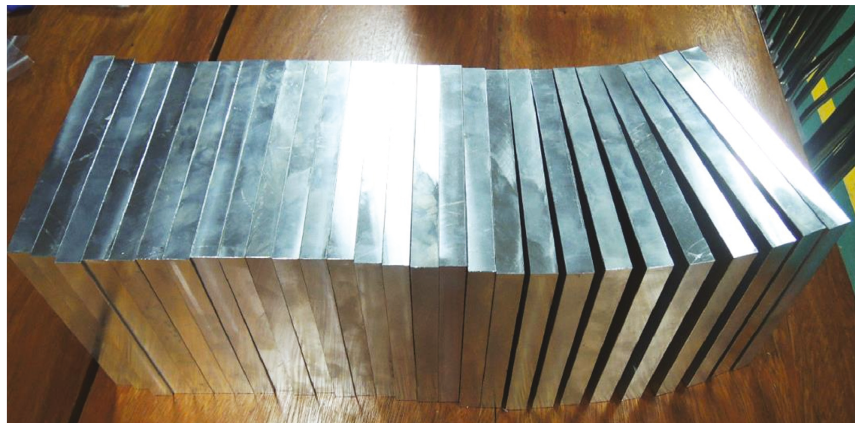
Figure 3: AISI 6061 aluminum alloy workpieces for experiments (with permission from [2] (open access)). Table 1: Chemical composition of AISI 6061 aluminum. Element Al Cr